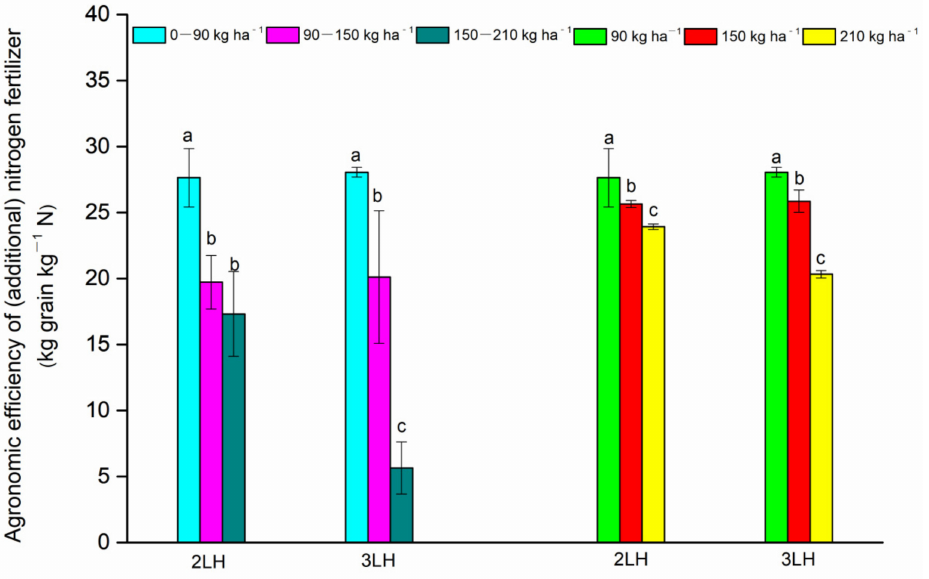
Figure 2. Agronomic efficiency of (additional) nitrogen fertilizer of two rice types. 2LH: two-line hybrid rice; 3LH: three-line hybrid rice. Different letters above the three adjacent bars represent significant difference at p < 0.05 among N